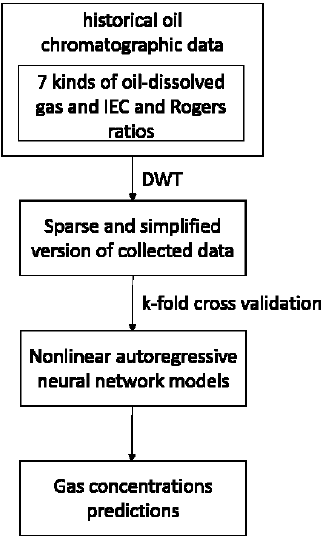
Figure 2. Flowchart of the proposed nonlinear autoregressive prediction model (NAR–DWT). Prediction of In-Oil Gas